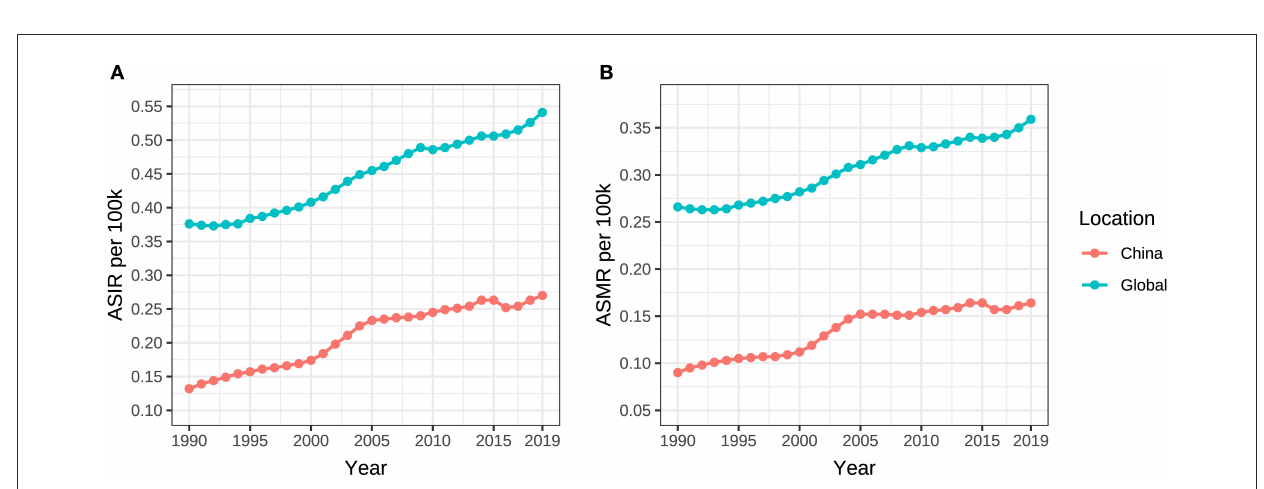
FIGURE2 ASIR and ASMR of ovarian cancer attributable to hyperglycemia from 1990 to 2019. (A) ASIR, (B) ASMR.